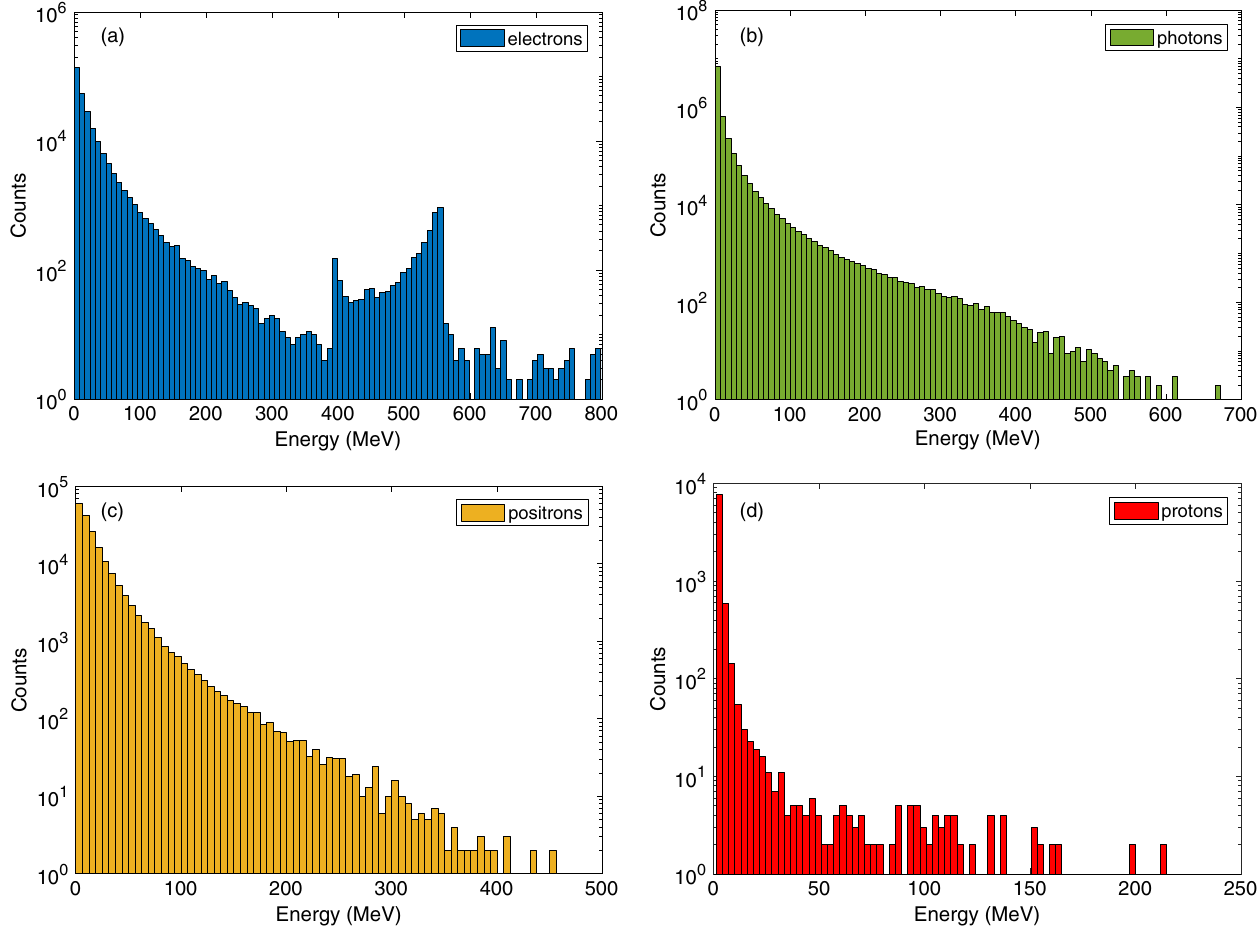
FIG. 15. Energy spectrum of the scattered and emitted electrons (a), photons (b), positrons (c), and protons (d) from the collimator after the interaction with the incoming electron beam. The particles have been collected over a 4 π solid angle around the